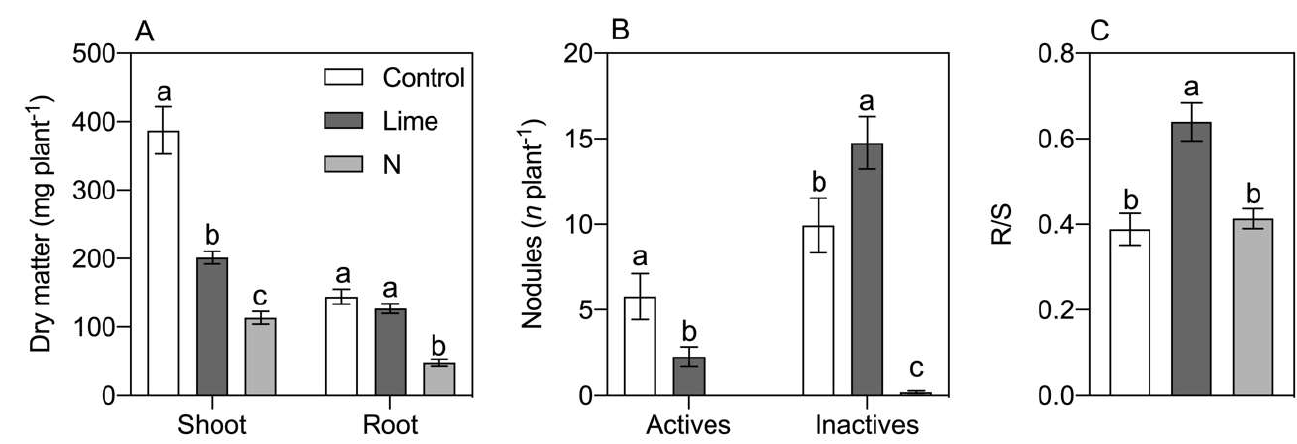
Figure 2. ( A ) Dry matter of shoots and roots produced by lentils grown in pots that were harvested 103 days after sowing, ( B ) number of active and inactive nodules, and ( C ) root to shoot ratio (R/S). Small letters indicate significant differences among treatments after Tukey’s test ( p < 0.05).